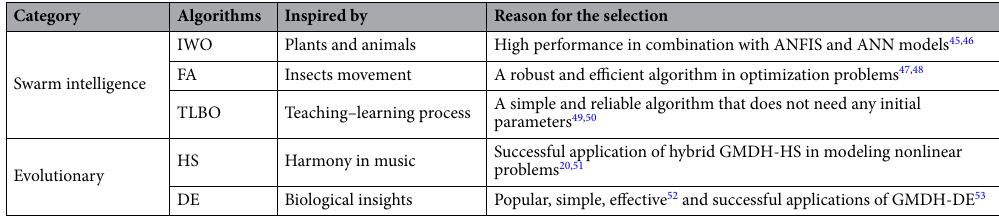
Table 1. Presentation of the meta-heuristic